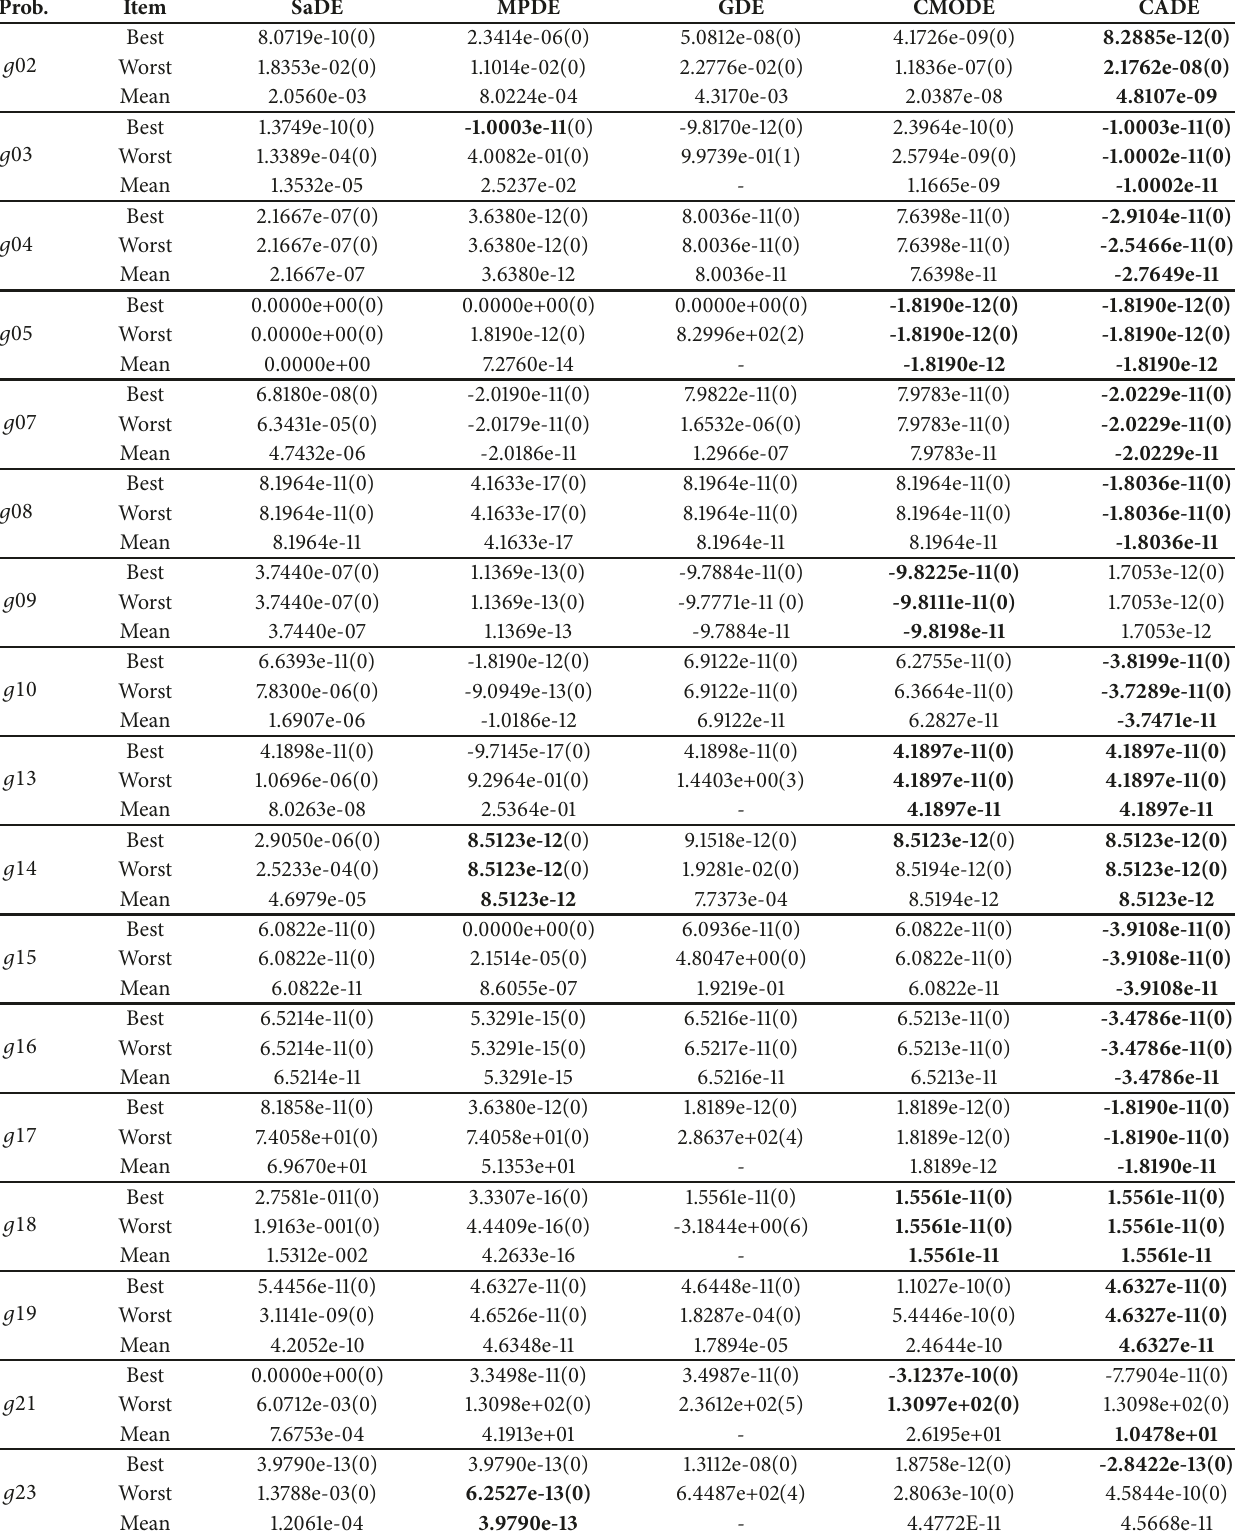
Table 8: Comparison of function error values achieved by five DE-based approaches when FES = 5 × 10 5 for test instances g02-g05, g07-g10, g13-g19, g21, and